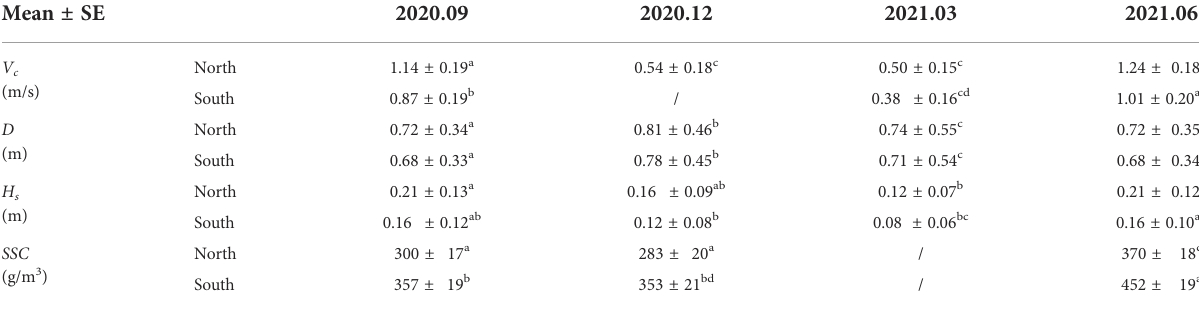
Different superscript letters indicate signi fi cant differences between different cases (P<0.05). Vc represented current velocity. D represented water depth. Hs represented wave height. SSC represented suspended sediment